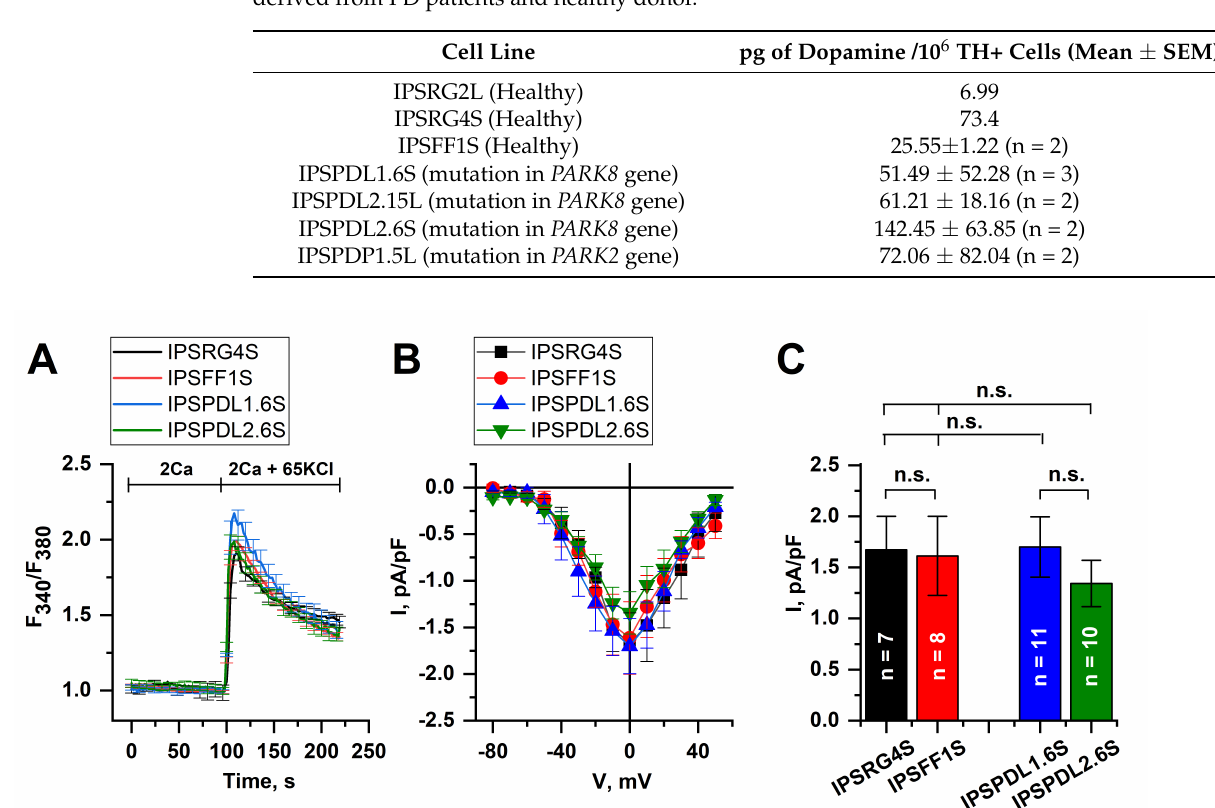
Figure 7. Depolarization-induced calcium influx in iPSC-derived DAns. ( A )—average fluores- cence amplitudes of calcium dye Fura-2 AM in DAns derived from PD patients (IPSPDL1.6S, blue line) and (IPSPDL2.6S, green line) with point mutation G2019S in PARK8 gene and healthy donors (IPSRG4S, black line) and (IPSFF1S, red line). The calcium influx was evoked by the application of 65 mM KCl that caused membrane depolarization and consequent calcium entry through voltage-gated channels. The curves are represented as mean ± SEM. ( B )—average I–V curves of normalized voltage- gated calcium currents in DAns specific for PD patients (IPSPDL1.6S, blue line and IPSPDL2.6S, green line) and healthy donors (IPSRG4S, black line and IPSFF1S, red line). The number of experiments is depicted in panel ( C ). ( C )—average amplitudes of voltage-gated calcium currents at the potential of 0 mV in DAns specific for PD patients (IPSPDL1.6S, blue bar) and (IPSPDL2.6S, green bar) and healthy donors (IPSRG4S, black bar) and (IPSFF1S, red bar). The amplitudes are represented as mean ± SEM (n = number of single-cell experiments), n.s. indicates the absence of statistically significant differences ( p >